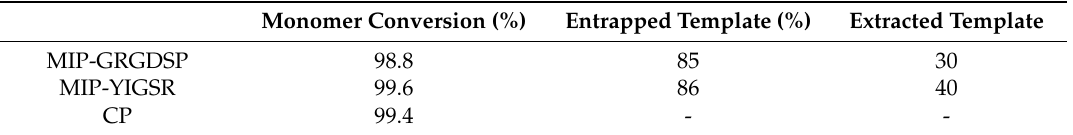
Table 2. Results of chromatographic analysis carried out on polymerization solution and extraction solution: conversion of monomer, percentage of template molecule entrapped by the polymer, and amount of template molecule extracted by repetitive